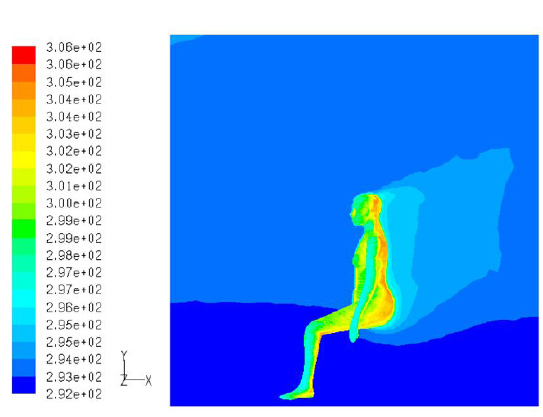
mannequin surface and is shown on Figure 4.